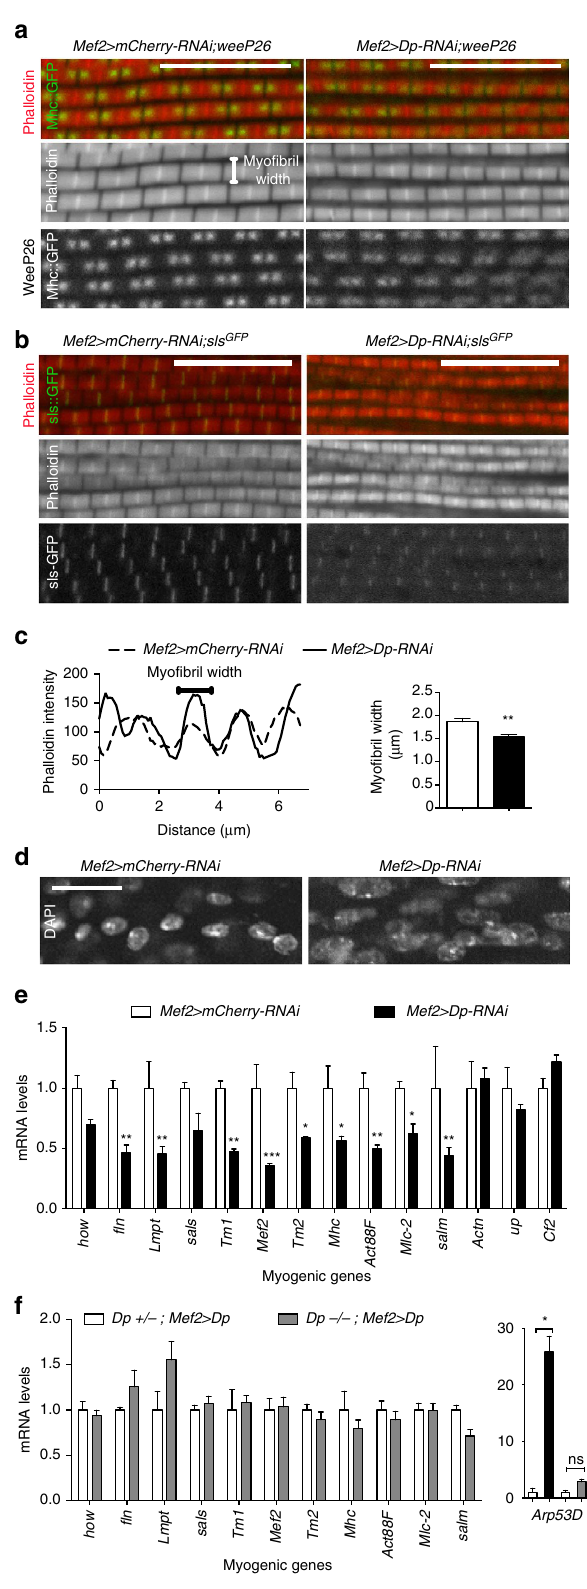
Figure 5 | E2F controls myofibrillogenesis in flight muscles by regulating myogenic gene expression. ( a – c ) Myobrils and sarcomeric proteins are slightly misassembled in Dp-depleted muscles at the pharate stage. Confocal images of DLMs in a sagittal view stained with Phalloidin (red) in a GFP-tagged splice variant Mhc-IFM19 background ( weeP26 ), to mark A-band structure ( a ), or in an Sls-GFP background to mark Z-band structure ( b ). Scale bar, 5 m m. ( c ) Profile plot of phalloidin intensity over distance. A line perpendicular to myofibril orientation was drawn to determine the number of myofibrils per distance. Quantification of myofibril width ( m m), mean ± s.e.m., N ¼ 8 and 7 hemithoraces per genotype, t -test with Welch’s correction, ** P o 0.01. ( d ) Nuclei are enlarged in Dp-depleted muscles. Confocal images of DLMs in a sagittal view stained with DAPI. Scale bar, 20 m m. ( e , f ) Muscle-specific gene expression is compromised in Dp-depleted flight muscles at the pharate stage, and rescued by overexpressing Dp only in muscles of Dp-mutant background. Muscle genes are how , fln , Lmpt , sals , Tm1 , Mef2 , Tm2 , Mhc , Act88F, Mlc2 , salm , Actn , Cf2 and upheld ( up, TpnT or wupB ). Mean ± s.e.m., N ¼ 3 independent samples per genotype, two-way ANOVA ( e ), Kruskal–wallis test ( f ), * P o 0.05, ** P o 0.01, *** P o 0.001. Genotypes are ( a – e ) Mef2-GAL4/UAS- mCherry-RNAi (left panel, white bar) and UAS-Dp-RNAi;Mef2-GAL4 (right panel, black bar), and ( f ) Dp a3 / þ ; Mef2-GAL4/UAS-Dp (white bar) and Dp a3 / Df(2R)Exel7124;Mef2-GAL4/UAS-Dp (grey